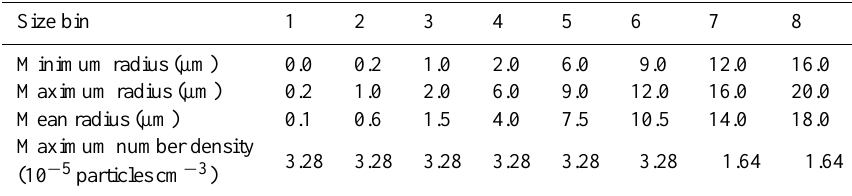
Table 2. The eight size bins in submodel PSC used for the kinetic growth NAT